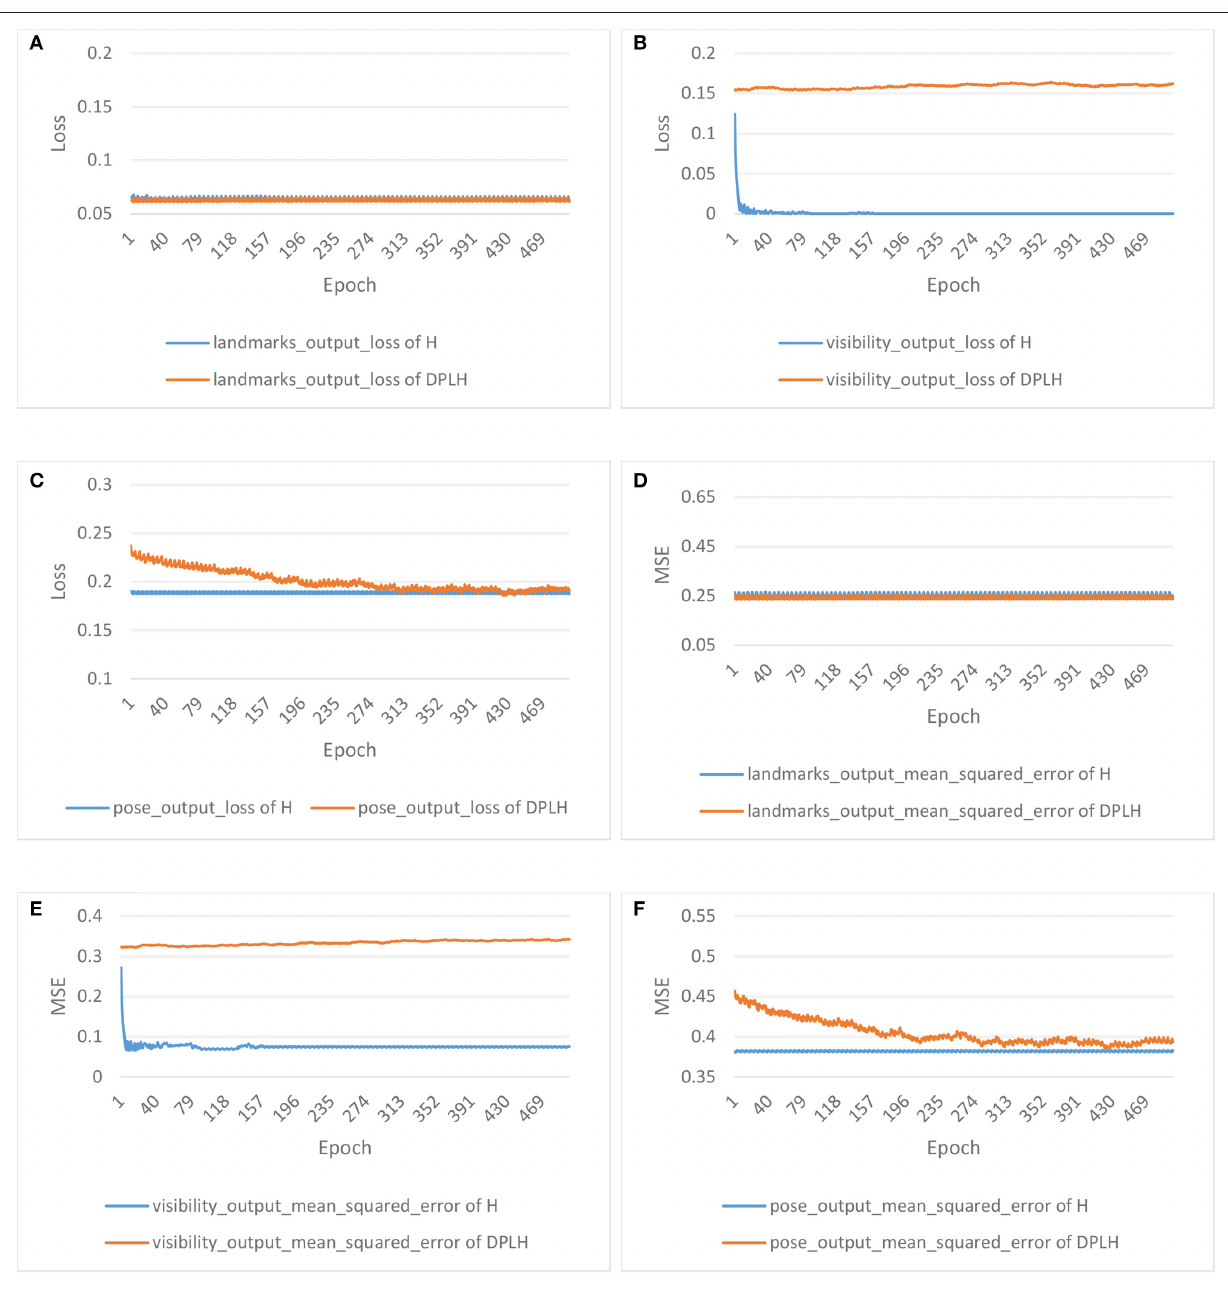
FIGURE 4 | Results for the loss and mean square error (MSE) of landmark localization, landmark visibility, and pose estimation on HyperFace(H) vs. DPLH. (A) Loss of landmark localization. (B) Loss of landmark visibility. (C) Loss of pose estimation. (D) MSE of landmark localization. (E) MSE of landmark visibility. (F) MSE of pose